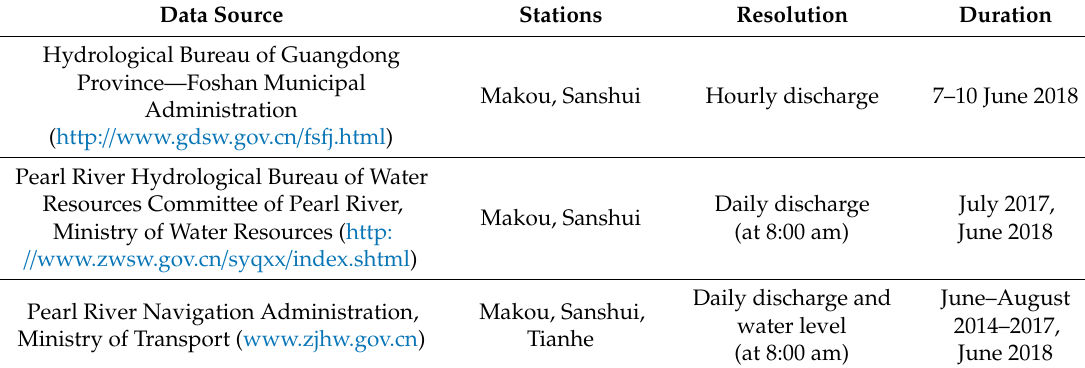
Table 1. River discharge data